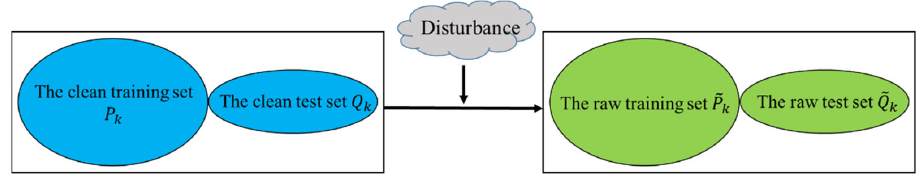
Figure 3. Relationship between the clean sets and the raw sets. The noise filtering model was obtained based on the noisy training set and test set.